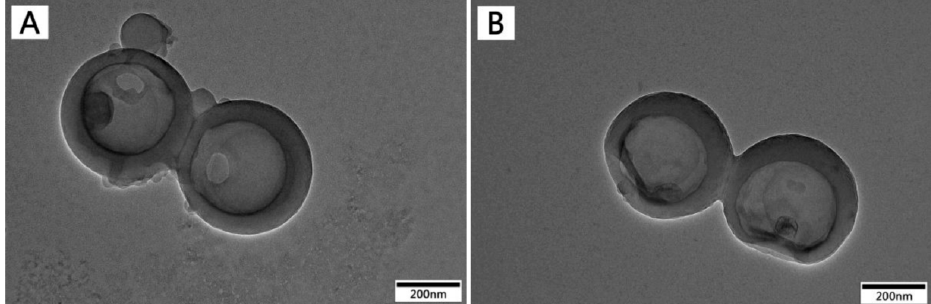
Figure 6. TEM images of ( A ) LHNPs@DOX, ( B ) FA-MLHNPs@DOX.